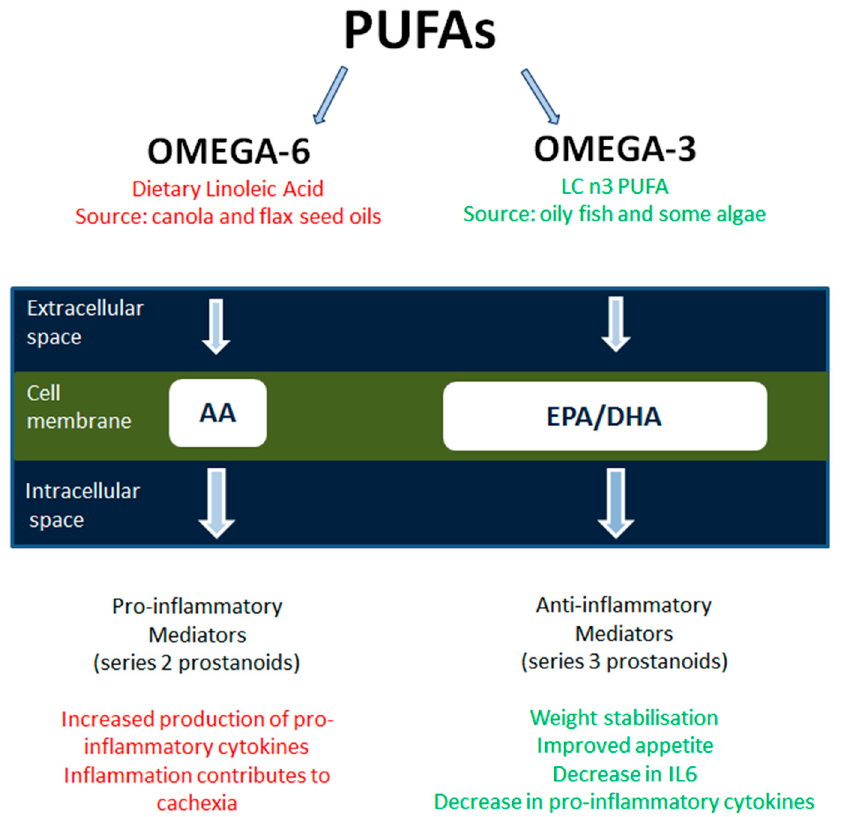
Figure 1. Essential n-3 and 6-PUFAs or omega-3 fatty acids ( ω -3FA) from dietary linoleic acid or oily fish (respectively). Arachidonic acid derives from the cleaving of phospholipids, and it contributes to cachexia symptoms by causing inflammation [77]. It has been hypothesised that the pro-inflammatory AA ω -6FA can be partly replaced by docosahexaenoic acid and eicosapentaenoic acid and stabilise weight and reduce pro-inflammatory cytokines produced by AA [68]. AA—Arachidonic Acid;